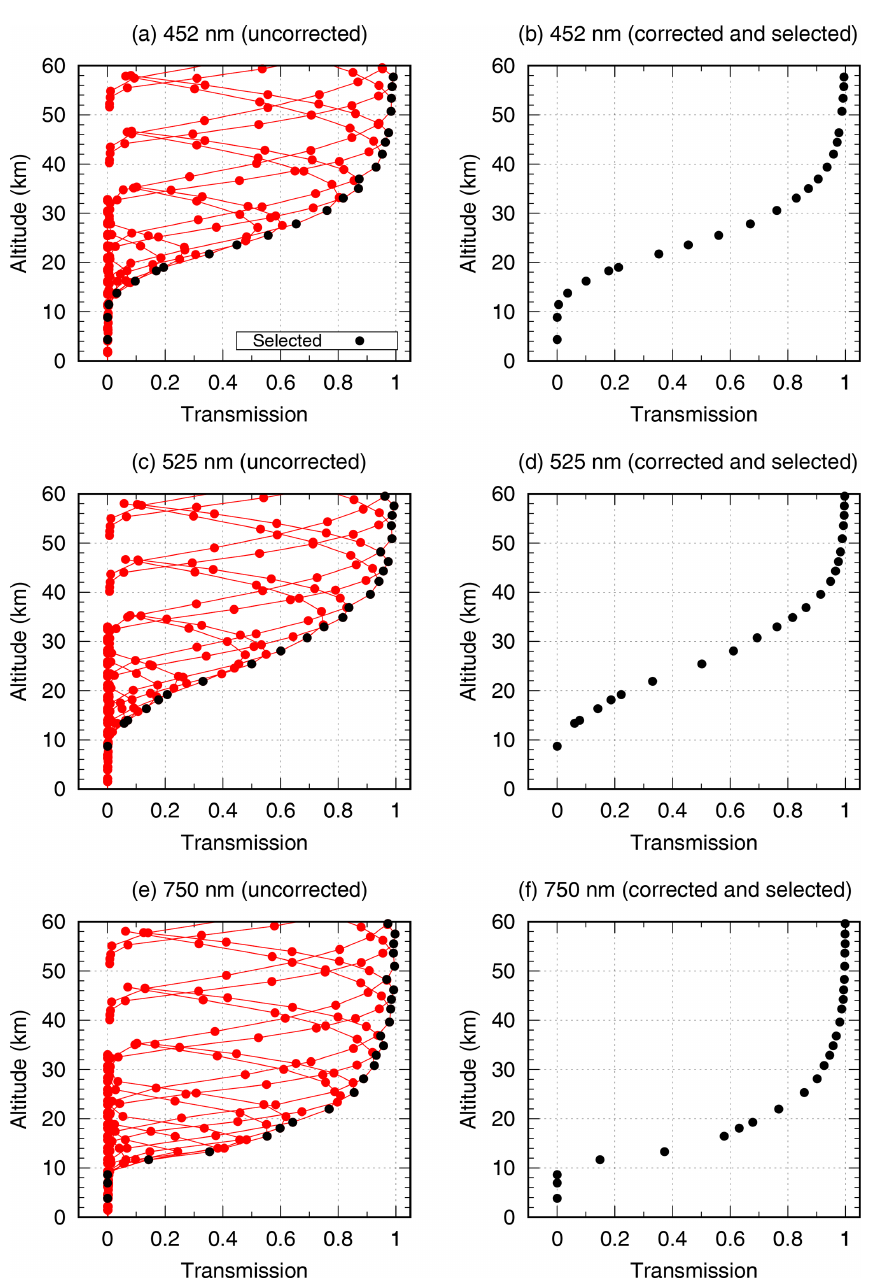
Figure 5. Transmissions for orbit 8014 (11 September 2003) and different wavelengths (top to bottom). (a, c, e) Uncorrected data (red) and selected subset (black). (b, d, f) Corrected and selected